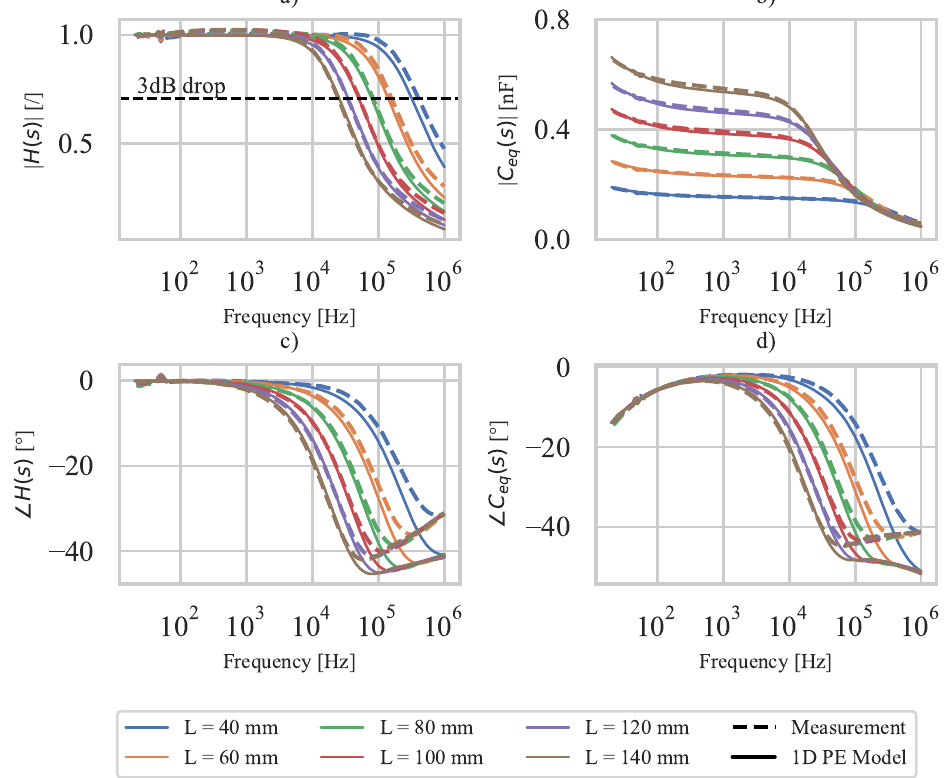
Figure 9. Measurement and 1D PE model comparison: ( a ) H ( s ) amplitude spectrum, ( b ) C eq ( s ) amplitude spectrum, ( c ) H ( s ) phase spectrum, ( d ) C eq ( s ) phase